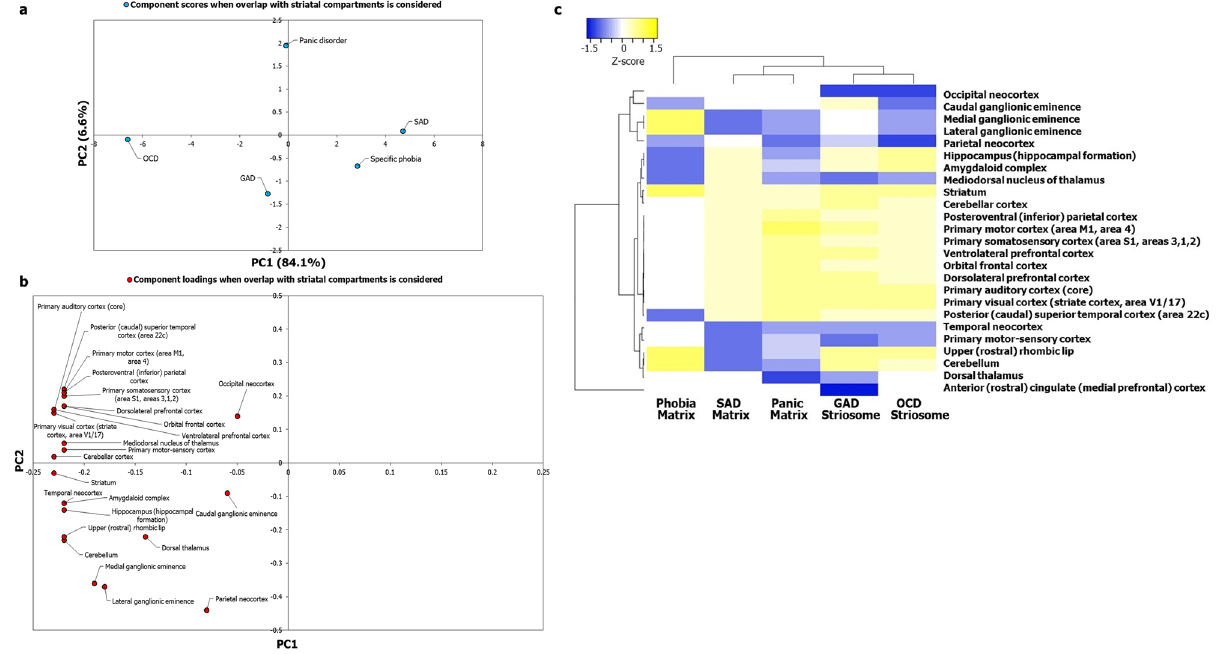
Figure 6. Principal component analysis and clustering analyses of AD-SMIs based on a larger expression dataset recapitulated the AD groups and revealed embryonic structures potentially relevant to anxiety etiology. ( a ) PCA was performed with the p values of enrichment of genes that co-occur in specific ADIs and SMIs. The enrichment of these genes among those expressed across 26 brain regions compiled from Allen Brain Atlas having log(RPKM) > 2 was checked. The statistical significance of region-wise enrichment was computed as p values. These values were transformed to − log 10 P values, and then assembled into a data matrix containing brain regions as rows and ADs as columns (represented as a heatmap in ( c )). Unit variance scaling was applied across this matrix. Single value decomposition (SVD) with imputation was used to extract the principal components (PCs). Component scores of GAD-striosome, OCD-striosome, phobia-matrix, SAD-matrix and panic disorder- matrix (n = 5) corresponding to PC1 and PC2 explaining 84.1% and 6.6% of the total variance were plotted along X and Y axes, respectively. ( b ) Component loadings of 24 dimensions, i.e., brain regions, contributing to PC1 and PC2 shown in ( a ) were plotted along X and Y axes, respectively. This figure recapitulates findings from GTEx data (Fig. 4c) with data from Allen Brain Atlas, namely, observation of clearer grouping patterns among ADs when the striatal overlap is taken into consideration and uneven contribution of multiple brain regions to these patterns such as medial ganglionic eminence, lateral ganglionic eminence and parietal cortex. ( c ) Variations in region-wise enrichment of genes between ADIs and SMIs are represented in the form of a heatmap. Specifically, normalized z–scores computed based on the –log 10 transformed p values, indicating the statistical significance of enrichment of GAD-striosome, OCD-striosome, phobia-matrix, SAD-matrix and panic disorder-matrix, are shown in the figure. Z-scores indicate relative enrichment of specific brain regions in the gene sets and are computed based on the number of standard deviations that separate a given p value from the mean. Clustering was performed using the hierarchical clustering method with average linkage. The dendrograms were derived from the clustering analysis based on the computation of Pearson correlation coefficients between the data points. Clustering of GAD with OCD and SAD with panic disorder seen with GTEx data in Fig. 4c is recapitulated here. Phobia was identified as a separate cluster altogether. The clustered heatmap was created using Heatmapper (http:// www. heatm apper.